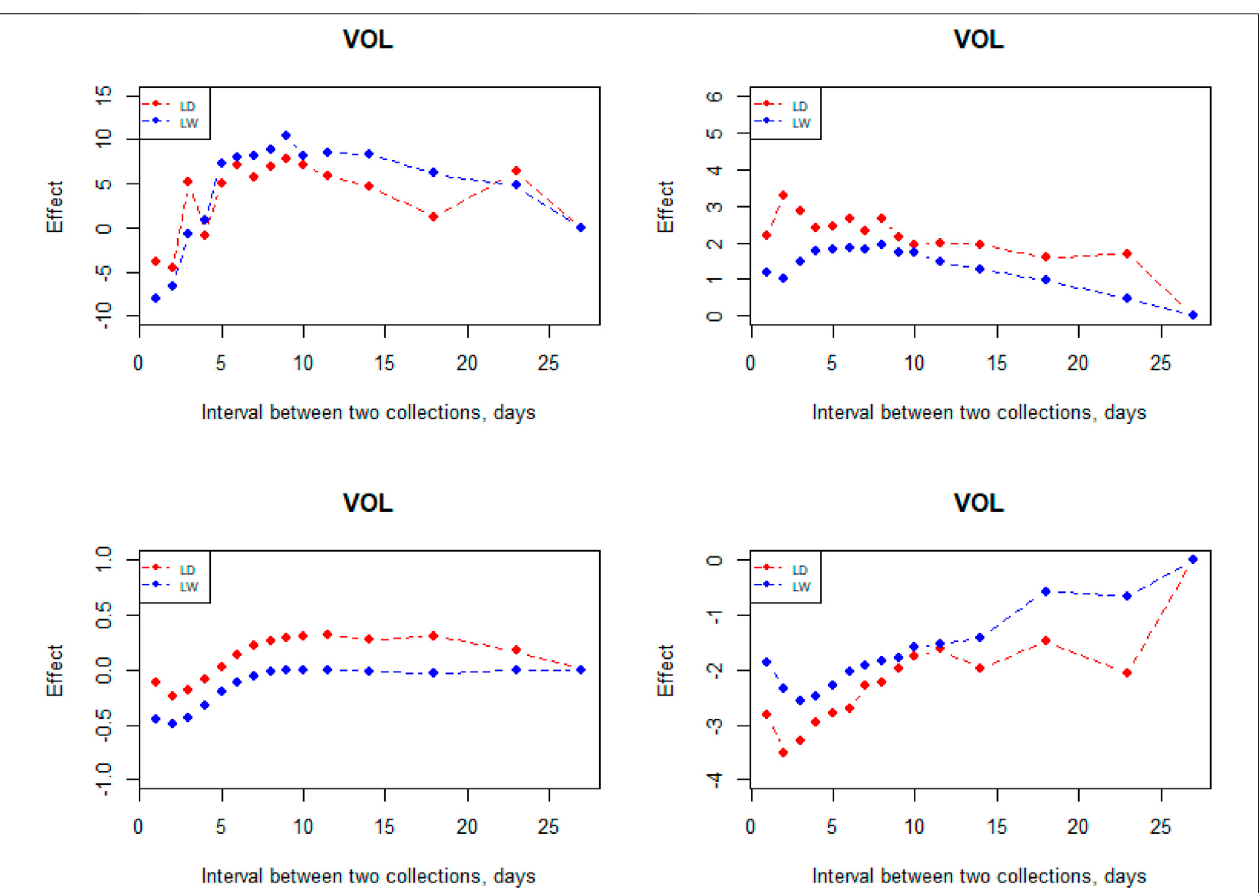
FIGURE 6 | Interval between two subsequent semen collections on semen